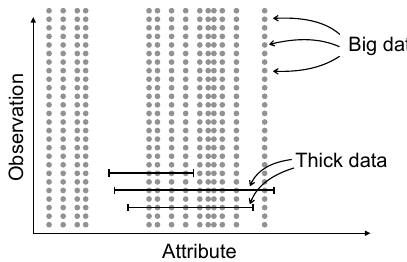
Fig. 2 Distinction between big and thick